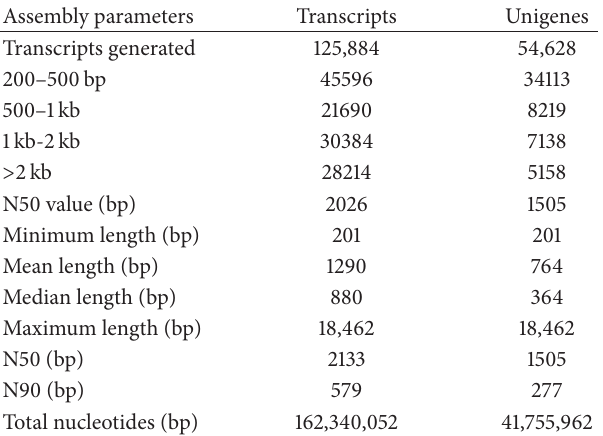
Table 1: Summary of de novo sequence assembly for Toona sinensis